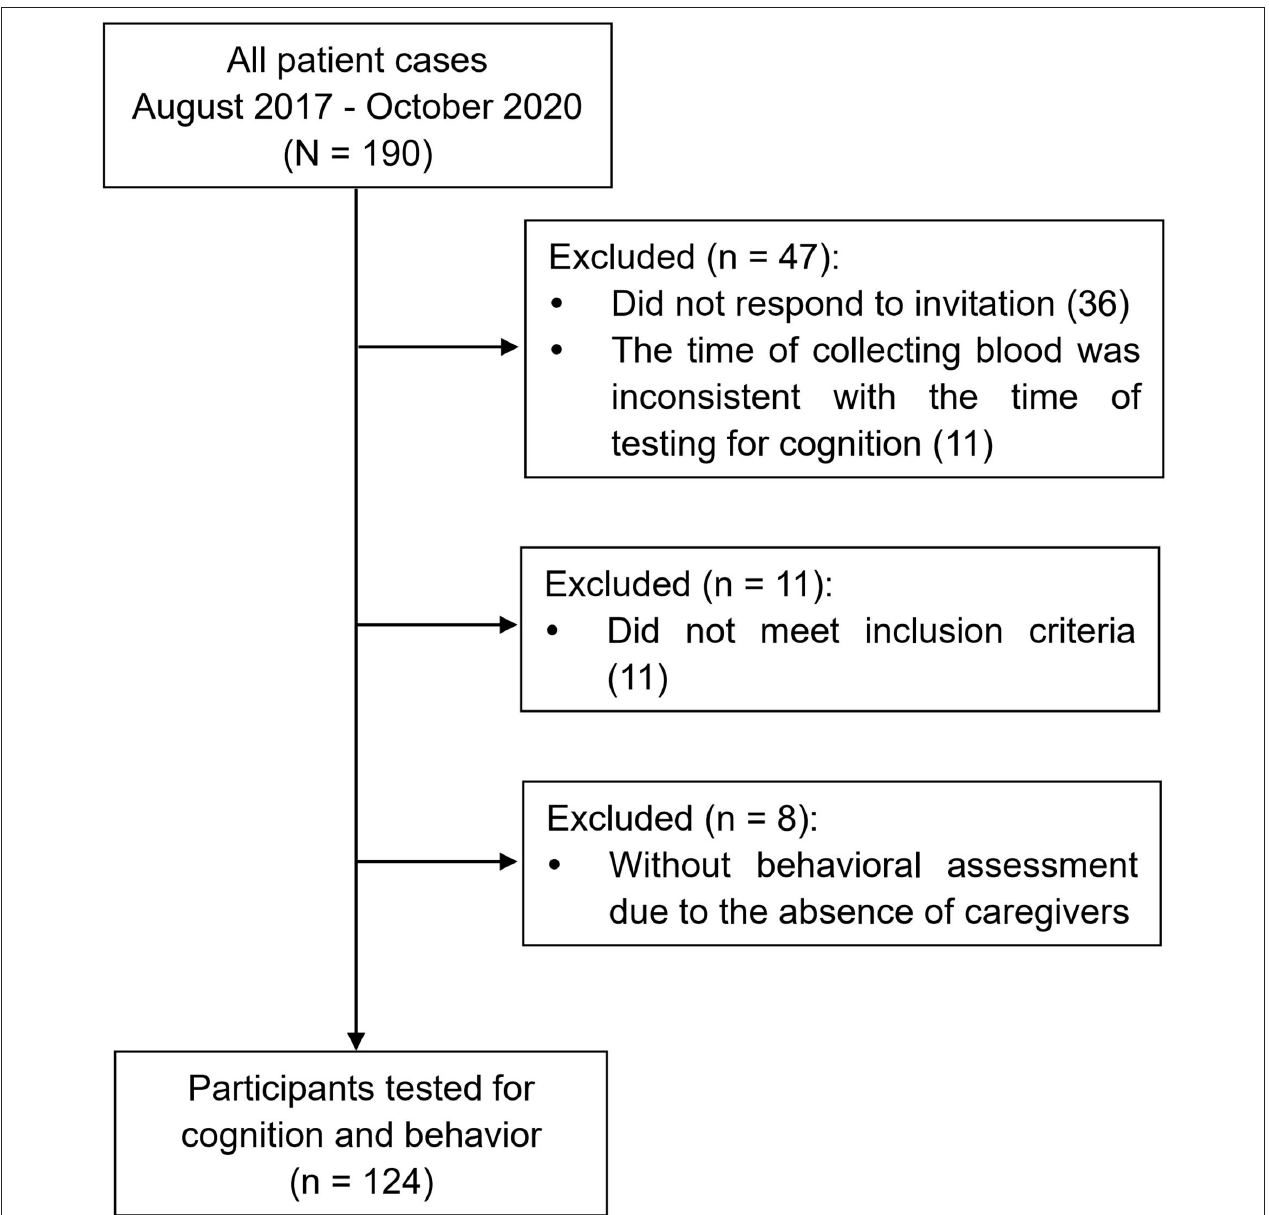
FIGURE 1 | Flow chart reporting the enrollment of cases.